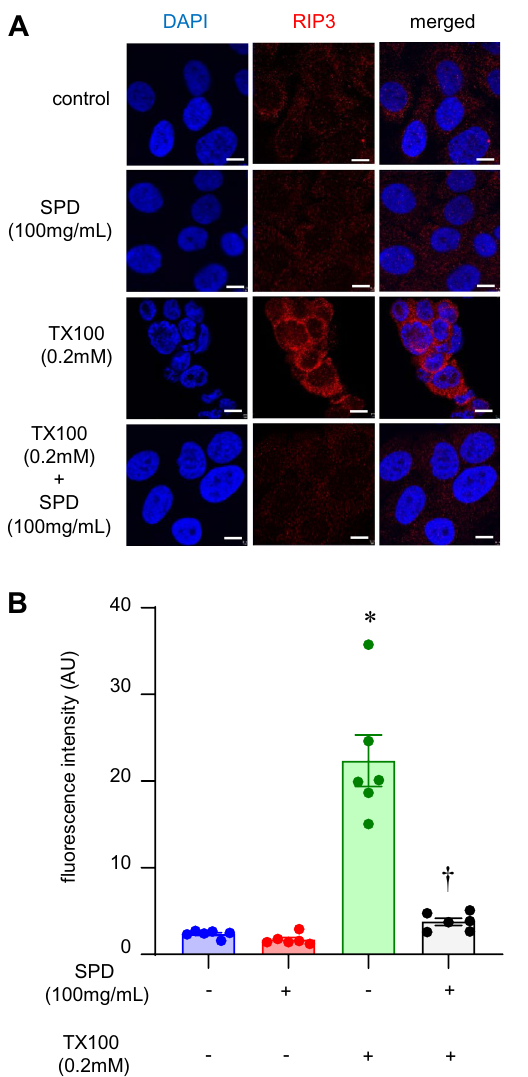
Figure 7. SPD blunted TX100-induced RIP3 expression. Human keratinocytes (HaCaT) were exposed to TX100 (0.2 mM) for 3 h in presence of SPD (100 mg/ml). Cells were then fixed and immunostained with RIP3 antibody. ( A , B ) Representative microscopic images and quantification of RIP3 expression was assessed by confocal microscopy. Scale, 10 µm. Data represent mean ± SEM (n = 6). * p < 0.05 compared to control (TX100- untreated). † p < 0.05 compared to TX100-treated